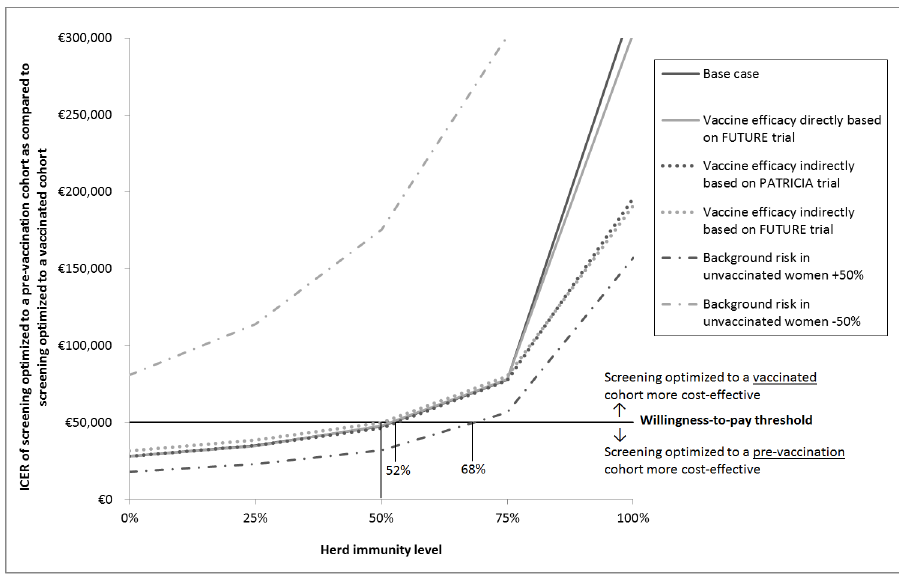
Fig 1. Incremental cost-effectiveness ratio (ICER) of screening optimized to a pre-vaccination cohort as compared to screening optimized to a vaccinated cohort, for unvaccinated women who benefit from different herd immunity levels, under both base case assumptions and sensitivity